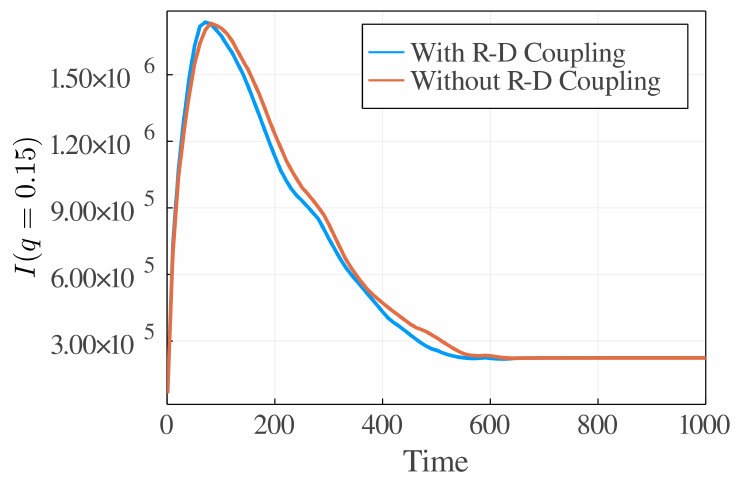
Figure 5. Comparision between the dynamic equations with (Equations (23) and (24)) and without (Equations (25) and (26)) reaction–diffusion coupling terms by showing their light scattering functions at different time steps at a fixed q . The numerical simulation is performed on a 256 × 256 lattice. D = 1.0, k 0 = 1.0, χ = 3.0, b A = 0.5, b B = 0.8 and ∆ τ = 0.05. The light intensity at q = 0.15 is (cid:82)(cid:82) evaluated by I ( q ) = d r 1 d r 2 φ A ( r 1 ) φ A ( r 2 ) sin q | r 1 − r 2 | / q | r 1 − r 2 |